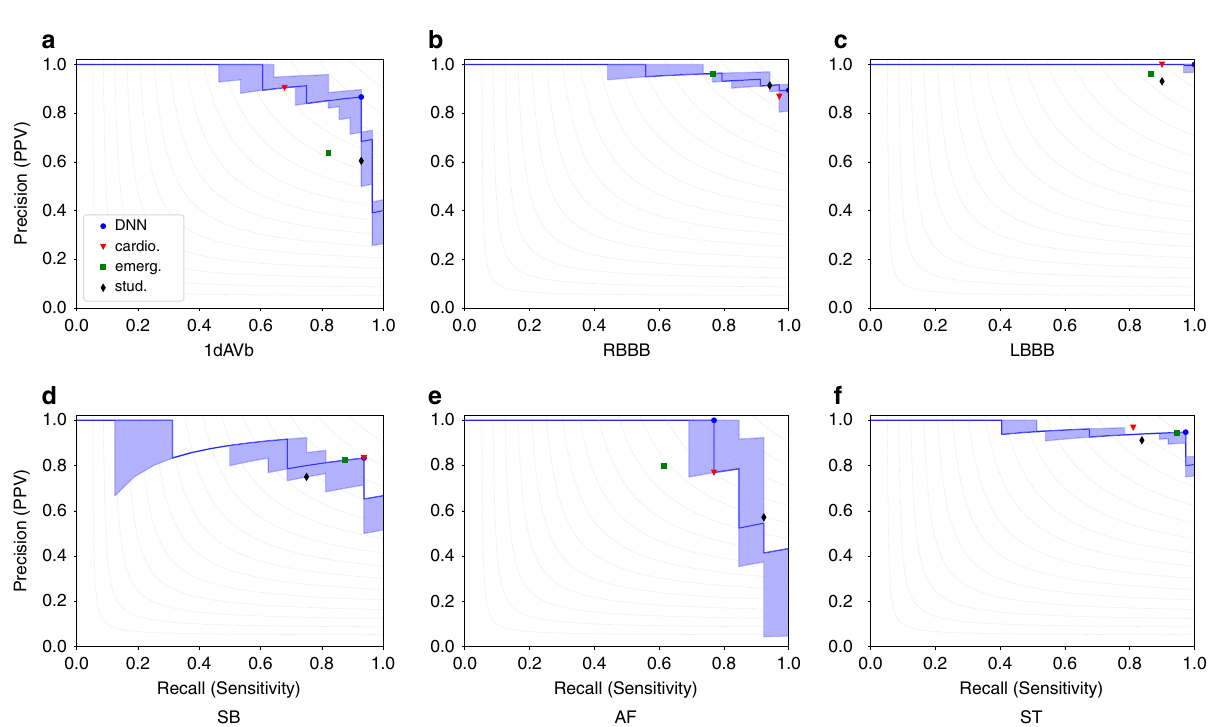
Fig. 2 Precision-recall curve. Show precision-recall curve for our nominal prediction model on the test set (strong line) with regard to each ECG abnormalities. The shaded region shows the range between maximum and minimum precision for neural networks trained with the same con fi guration and different initialization. Points corresponding to the performance of resident medical doctors and students are also displayed, together with the point corresponding to the DNN performance for the same threshold used for generating Table 2. Gray dashed curves in the background correspond to iso- F 1 curves (i.e. curves in the precision-recall plane with constant F1